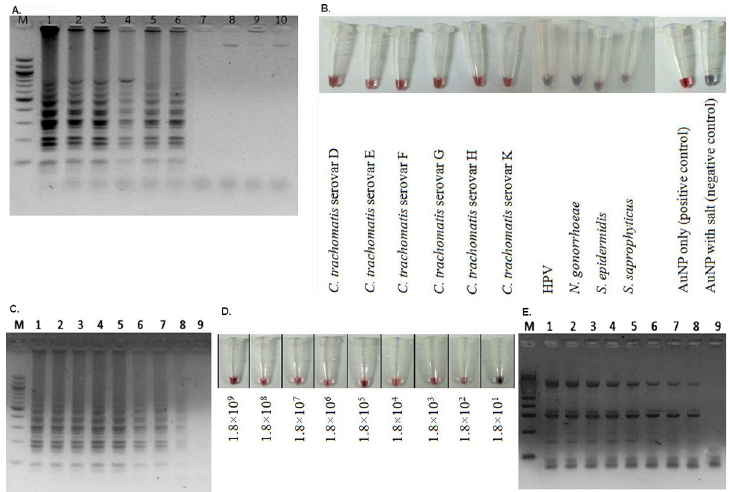
Fig 1. Detection of C . trachomatis by LAMP-GE (A and C), LAMP-AuNP (B and D), and PCR-GE (E). (A, B) Specificity determination using C . trachomatis serovars D, E, F, G, H, and K (from left to right, lane numbers 1–6) and HPV, N . gonorrhoeae , S . epidermidis , and S . saprophyticus (lanes 7–10). Additional controls in B included AuNPs only and AuNPs with salt. (C, D, E) The positive results were observed from lanes 1 to 8, representing a detection limit of 180 genome copy numbers of ompA (equivalent to 0.085 fg of ompA ), using C . trachomatis strain D. Lane 9 is 18 genome copy numbers of ompA (equivalent to 0.017 fg of ompA ). M represents GeneRuler 100 bp plus DNA ladder (Invitrogen, New York). AuNP, gold nanoparticle probe; Ct , Chlamydia trachomatis ; GE, gel-electrophoresis; HPV, human papillomavirus; LAMP, loop-mediated isothermal amplification; LOD, limit of detection; ompA , outer membrane protein A; PCR, polymerase chain